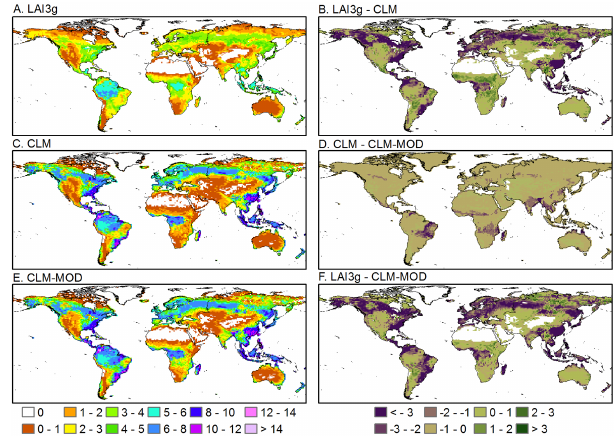
Figure 6. Maximum annual LAI averaged across the 29-year time period (1982–2010) in LAI3g, CLM, and CLM-MOD, and the dif- ferences between these three